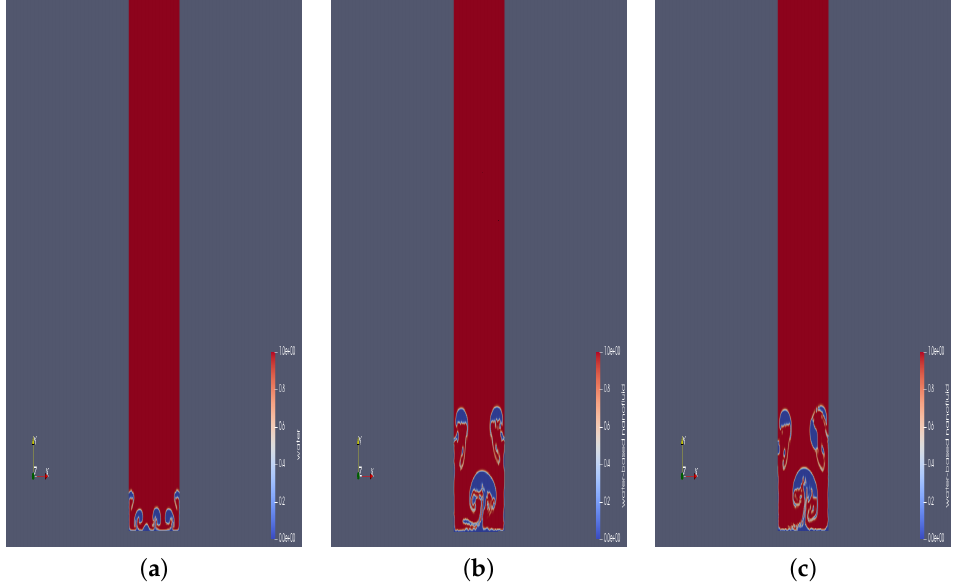
Figure 16. Solutions for multi-phase mixtures at time t = 10 s and ϕ = 0.2. ( a ) Water. ( b ) Water-Al 2 O 3 nanofluid. ( c ) Water-TiO 2